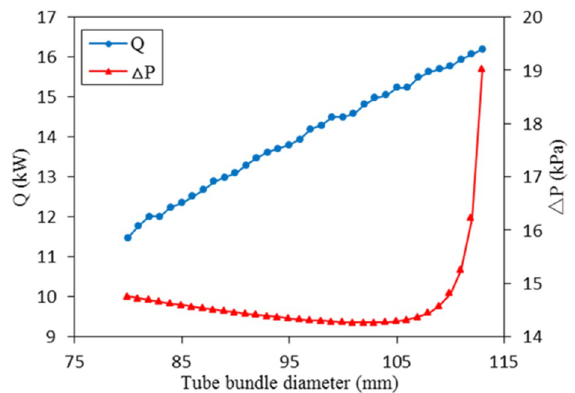
Figure 6. Heat transfer capacity and shell-side pressure drop separately versus tube bundle diameter.